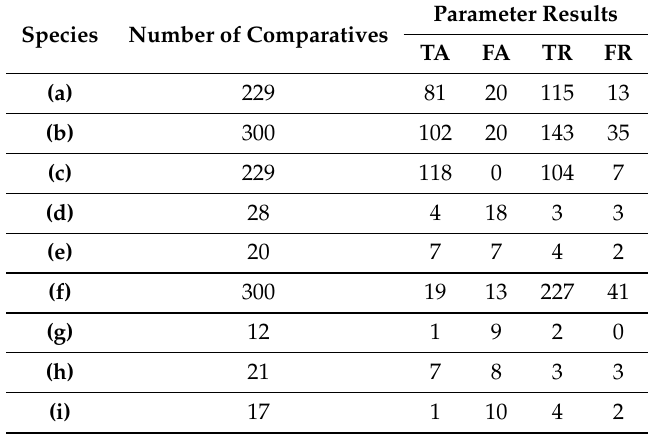
Table 3. Identification evaluation of the semi-automatic algorithm.